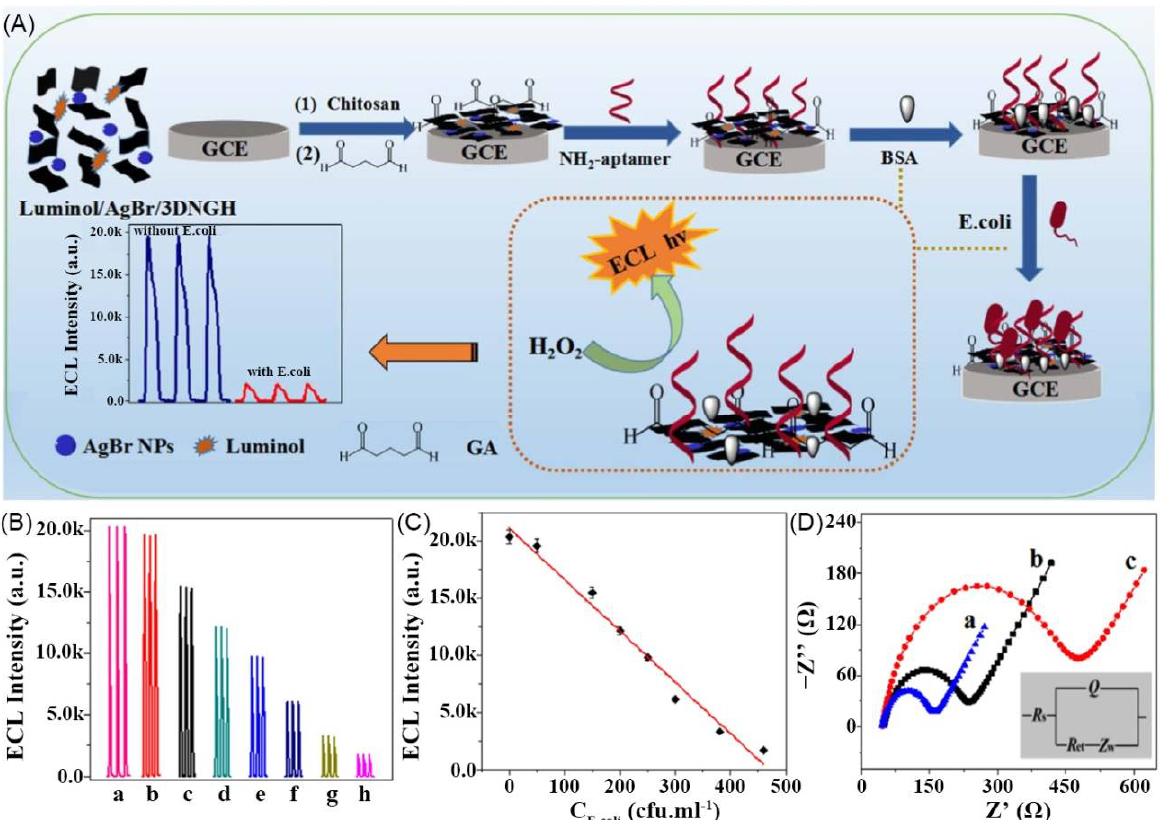
Figure 7. ( A ) Schematic of fabrication process of luminol/AgBr/3DNGH-based ECL E. coli biosensor. ( B ) ECL responses of BSA/aptamer/GA/CHIT/luminol/AgBr/3DNGH/GCE in 0.1 M PBS (pH 8) with different concentrations of E. coli. ( C ) Calibration curve for E. coli detection. ( D ) EIS of GA/CHIT/luminol/AgBr/3DNGH/GCE (a), BSA/aptamer/GA/CHIT/luminol/AgBr/3DNGH/GCE nanocomposites before (b) and after (c) E. coli reaction. Adapted with permission [94]; copyright 2017, Elsevier Ltd.